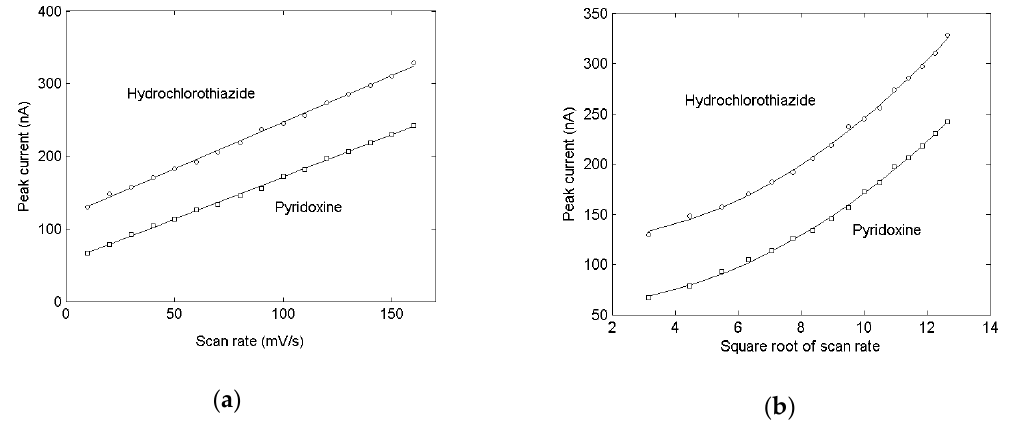
Figure 2. Effect of scan rate ( a ) and square root of scan rate ( b ) on peak current of the drugs.